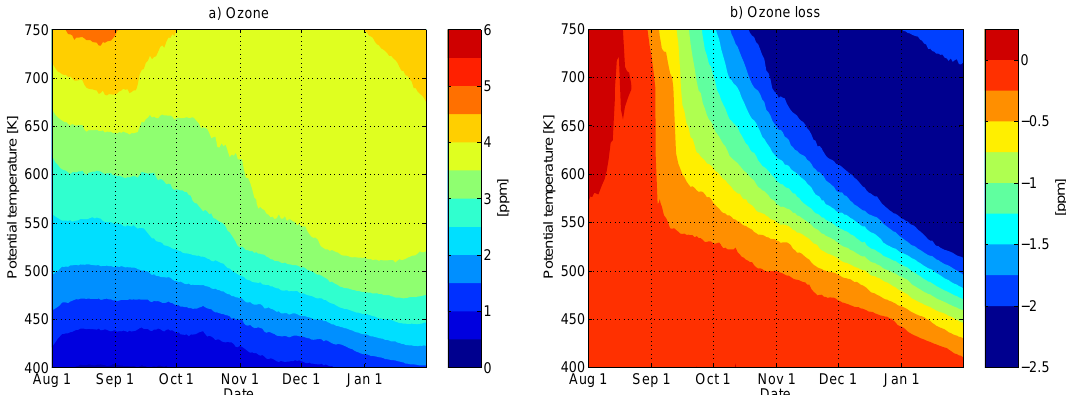
Fig. 1. (a) Mean ozone mixing ratios as a function of potential temperature and time, averaged over equivalent latitudes greater than 65°N. (b) Same for the ozone loss as the difference between the passive ozone tracer and modeled